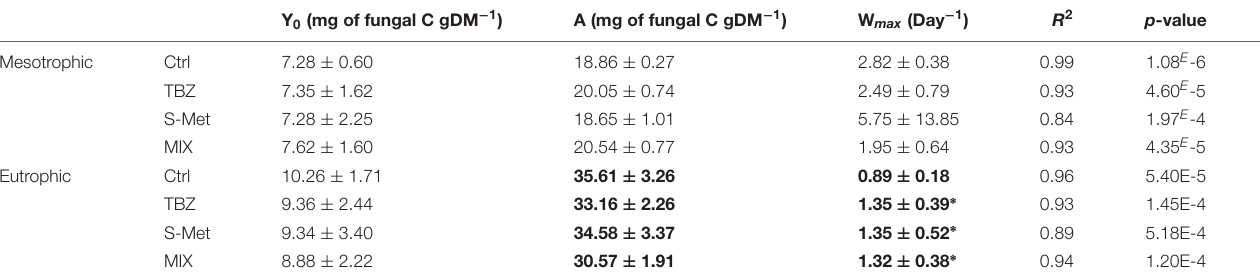
TABLE 4 | Parameters extracted from the measured fungal biomass after fitting to a logistic growth model in experimental stream channels exposed to fungicide (TBZ), herbicide (S-Met), both fungicide + herbicide (MIX) or non-exposed (Ctrl), in either mesotrophic or eutrophic nutrient condition.